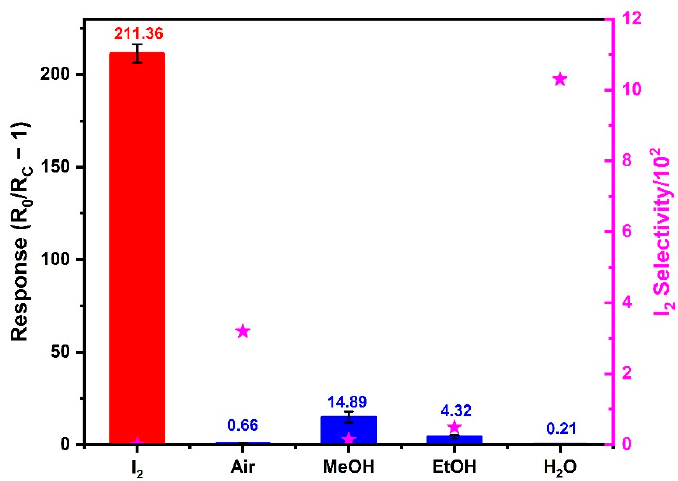
Figure 4. The gas response (histograms) and selectivity (stars) of AQ-COF-based IDE sensor towards various gaseous molecules. various gaseous